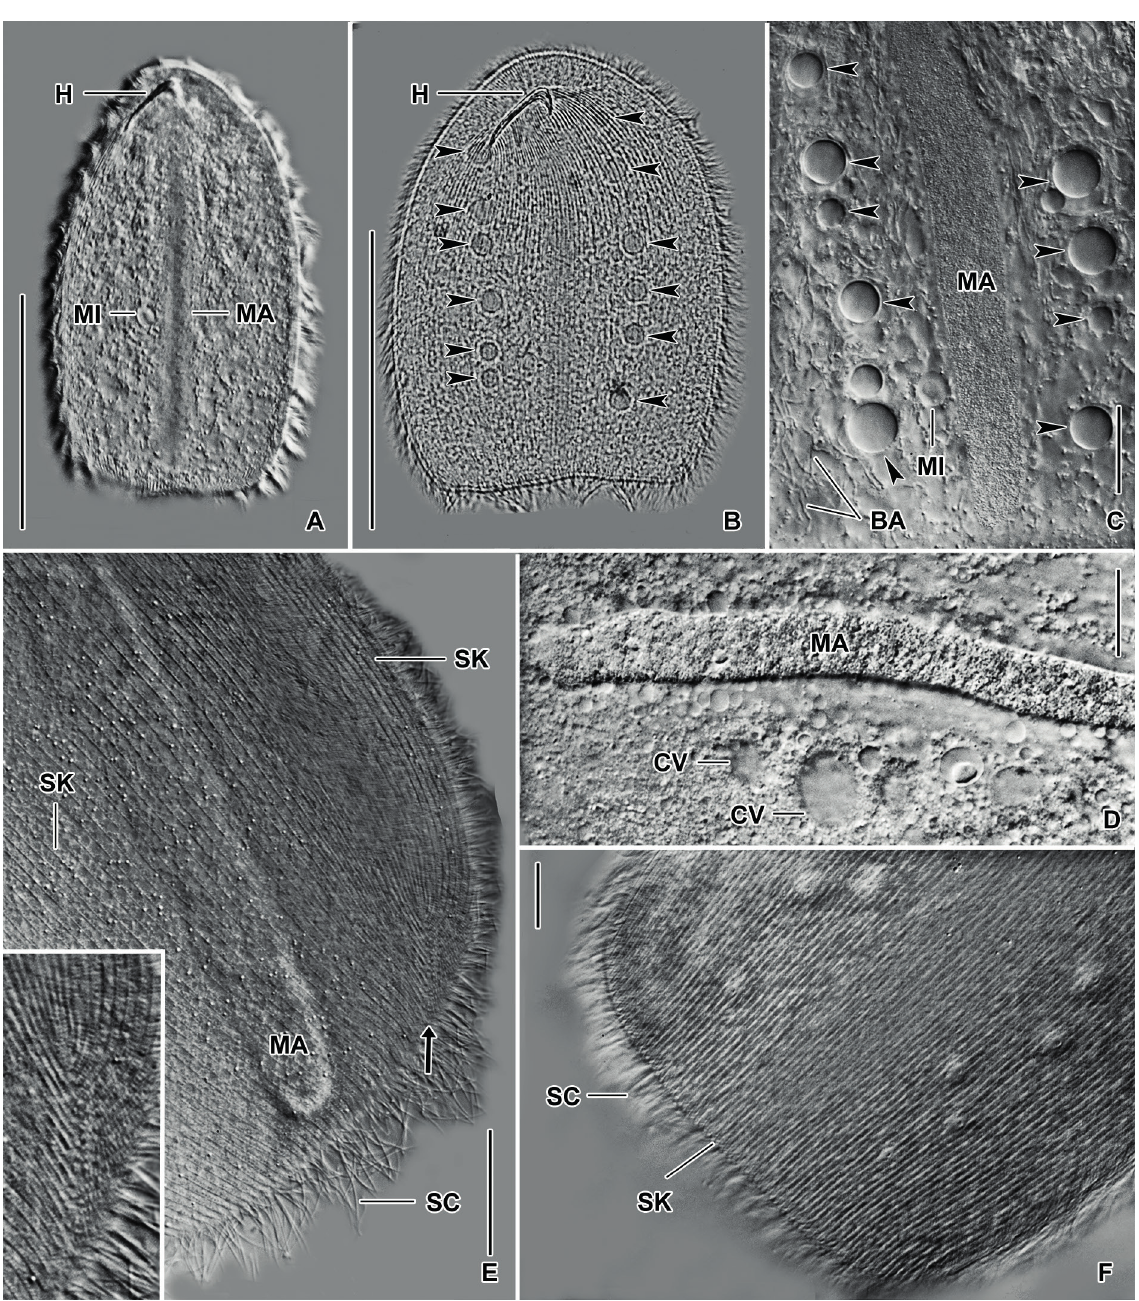
Fig. 4. Metaradiophrya lumbrici (Dujardin, 1841), Slovak specimens in vivo . A–B . Ventral view of representative specimens, showing the typical body shape, localization of the fibrillar hook, the long rod-like macronucleus and two staggered rows of contractile vacuoles (arrowheads). C–D . Detail, showing the long rod-like macronucleus, a single micronucleus, contractile vacuoles and cytoplasmic bacteria. The central region of the micronucleus appears homogenous and brighter than its margin in the differential interference optics and might represent a central nucleolus. E–F . Somatic ciliature is holotrichous and composed of very densely ciliated meridional kineties. In the posterior body region, lateral somatic kineties form a right and a left subterminal suture (arrow in E), whose detail is shown in the left inset. Scale bars: A–B = 100 µm; C–D = 10 µm; E–F = 20